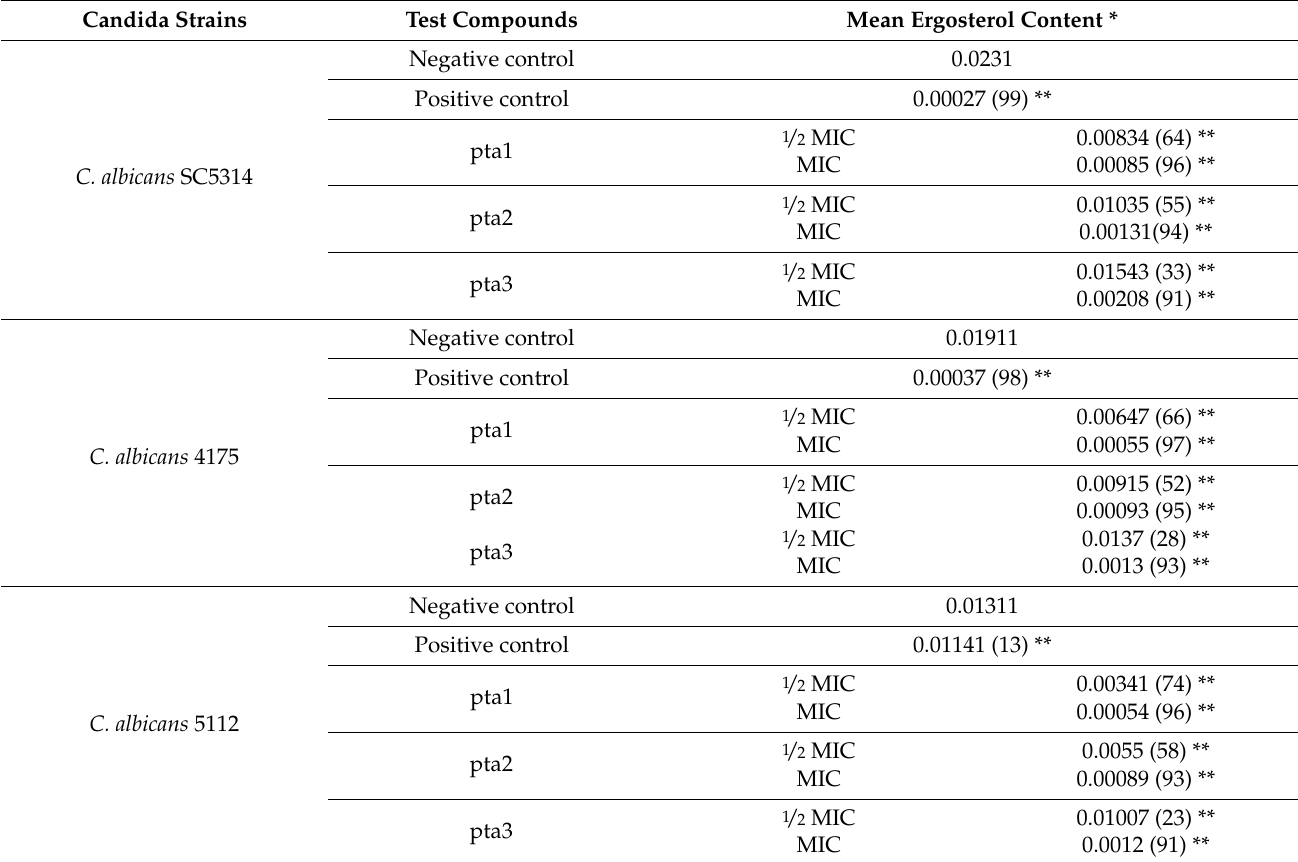
Table 3. Percentage reduction of ergosterol